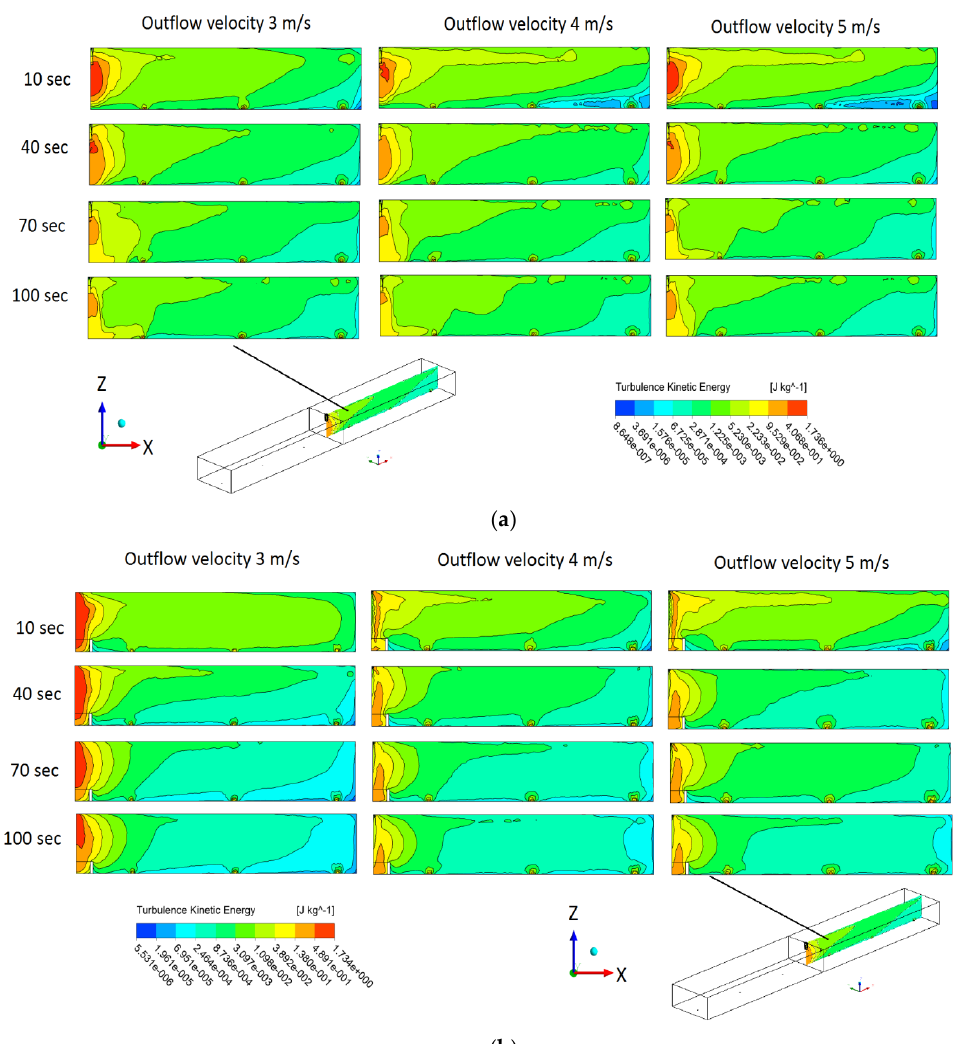
Figure 9. Turbulent kinetic energy contours are shown on middle plane of ( a ) bare tundish, and ( b ) tundish having APB.